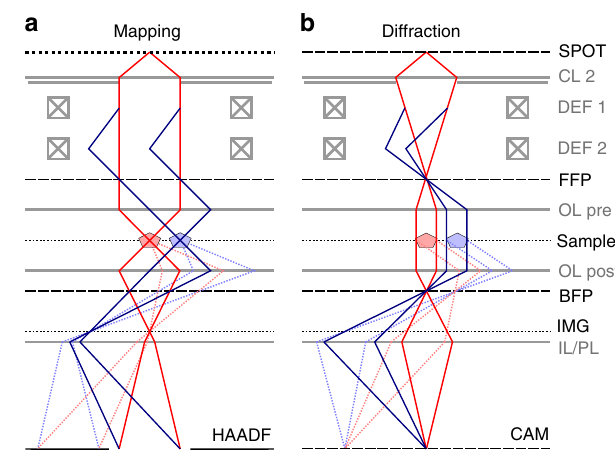
Fig. 4 Ray path diagrams for mapping (focused) and diffraction (collimated) condenser con fi guration. Red and blue lines correspond to on-axis and one exemplary off-axis positions of the beam. Dotted lines correspond to a Bragg re fl ection. Optical planes and electron-optical elements are shown in black and gray, respectively. a In the mapping con fi guration, the beam is collimated by the lower condenser lens (CL 2) and focused on the sample using the objective lens pre- fi eld (OL pre). Scattered beams from the illuminated sample position are imaged on the high-angle annular dark fi eld (HAADF) detector using the objective lens post- fi eld (OL post) and the intermediate and projection lenses (IL/PL). b In the diffraction con fi guration, on the other hand, the condenser focuses the beam on the front-focal plane (FFP) of the objective. Diffraction orders now appear as discrete spots on the diffraction detector (CAM). Note that switching between these con fi gurations involves changing of the CL 2 excitation only, as the detectors always remain in a plane conjugate with the back and front-focal planes of the objective lens (diffraction mode). SPOT — fi rst condenser lens (spot) crossover; DEF1/2 — upper and lower beam de fl ector pair; IMG — intermediate image